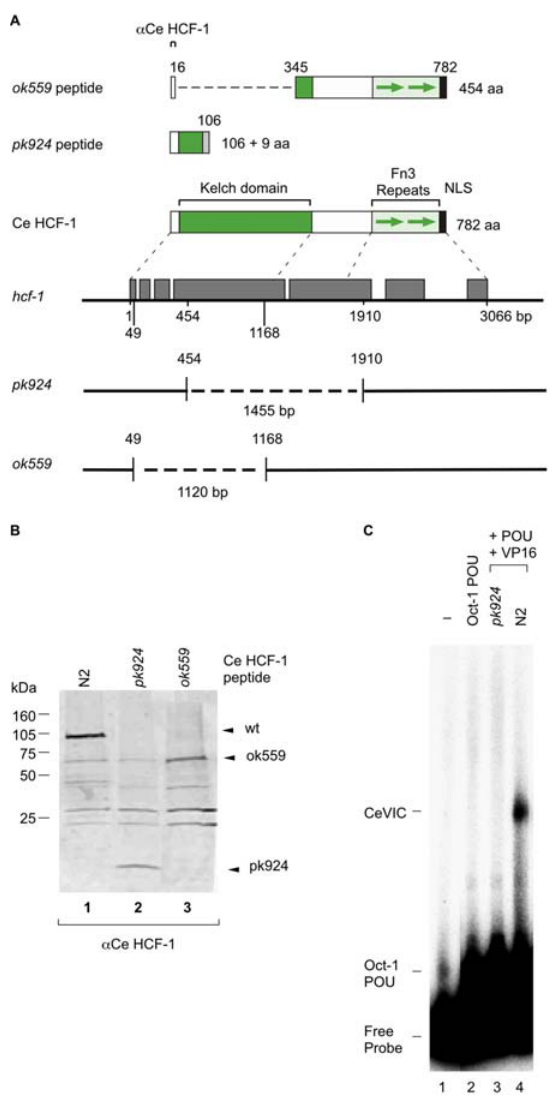
Figure 1. C.eleganshcf-1deletion mutants. (A) A schematic diagram of the C. elegans hcf-1 gene and deletions with predicted protein structures. The hcf-1 gene is shown in the middle with gray boxes indicating coding segments. Genomic distances from the start to end of the coding sequence along with deletion end points are indicated. The 782 amino acid Ce HCF-1 protein is shown illustrated above the hcf-1 gene schematic showing conserved Kelch domain, fibronectin type 3 (Fn3) repeats, and nuclear localization signal [35]. The residues flanking the deletions (454 and 1910 for pk924 , and 49 and 1168 for ok559 ) are indicated below. The ok559 deletion is in frame whereas the pk924 deletion creates an in frame stop codon 27 bp after the deletion junction creating the predicted polypeptides illustrated at the top. (B) Immunoblot analysis of Ce HCF-1 expression in N2 (lane 1), pk924 (lane 2), and ok559 (lane 3) L1-stage worms using the anti-Ce HCF-1 antisera. The lanes are from a single immunoblot in which intervening lanes have been removed. ( C) The absence of HCF activity in the deletion mutant tested by electrophoretic mobility retardation assay. Electrophoretic mobility retardation analysis of VP16-induced complex formation with probe alone (lane 1) or with added Oct-1 POU domain, VP16, and pk924 or wild-type N2 worm extracts as indicated (lanes 2–4). Mobilities of the free probe, and Oct-1 POU domain (Oct-1 POU) and VP16-induced (CeVIC) complexes are